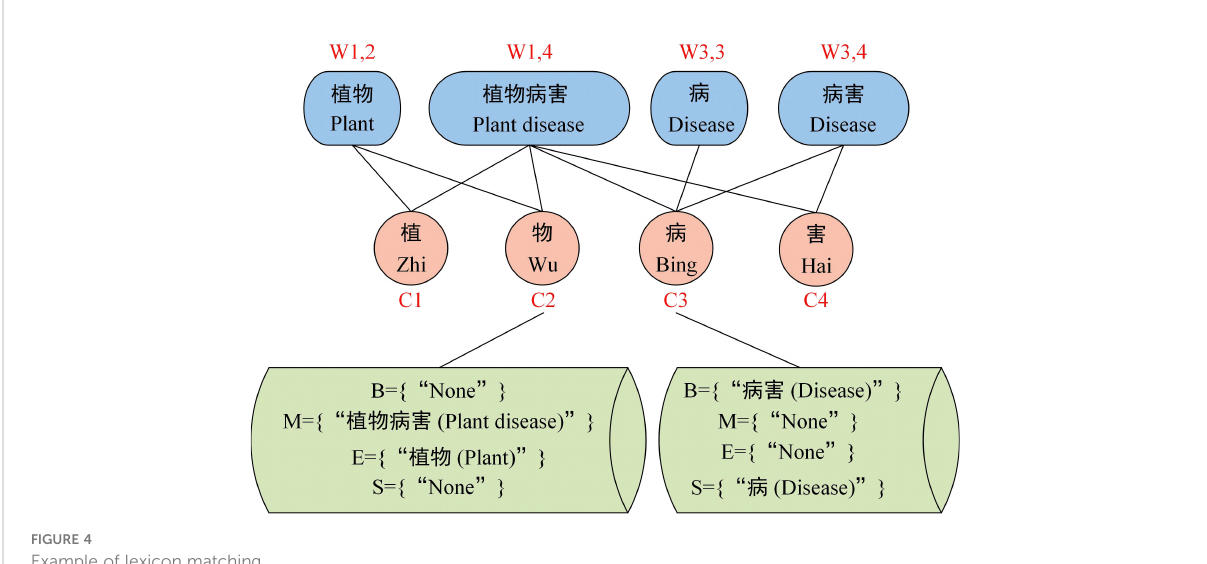
FIGURE 4 Example of lexicon